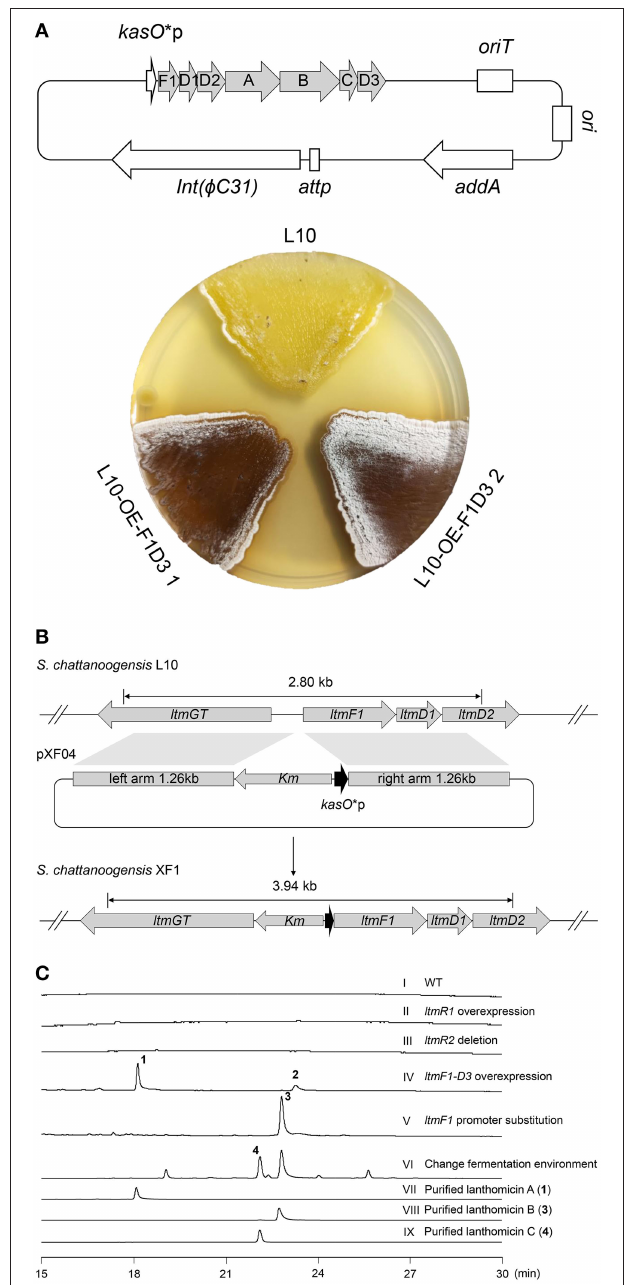
FIGURE 2 | Activation of cryptic lanthomicin gene cluster by promoter knock-in and changing cultivating environment. (A) Lanthomicins were produced on a solid YMG plate by overexpression of ltmF1-D3 cassette. (B) Schematic of a promoter replacement strategy that a Km - kasO *p cassette was inserted upstream of the ltmF1 gene and replaced the native promoter by homologous recombination. (C) HPLC analysis of the metabolites from different strains (UV at 480nm): (I) S. chattanoogensis L10; (II) S. chattanoogensis L10-OE-R1; (III) S. chattanoogensis L10- 1 R2; (IV) S. chattanoogensis L10-OE-F1D3; (V) S. chattanoogensis XF1; (VI) S. chattanoogensis XF1 (changing fermentation environment); (VII) isolated lanthomicin A; (VIII) isolated lanthomicin B; and (IX) isolated lanthomicin